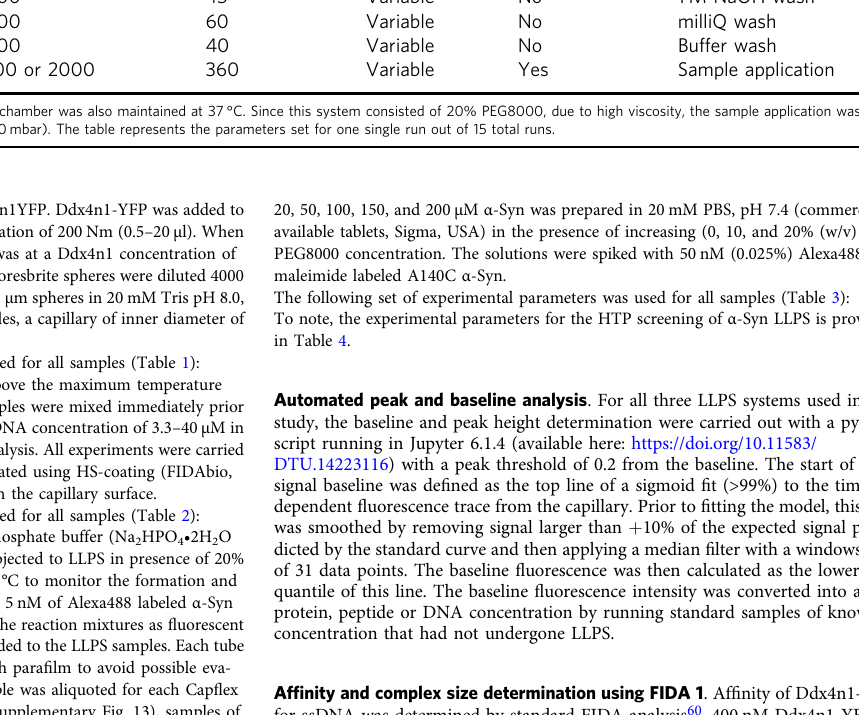
(cid:129) 2H 2 HPO 4 2 O